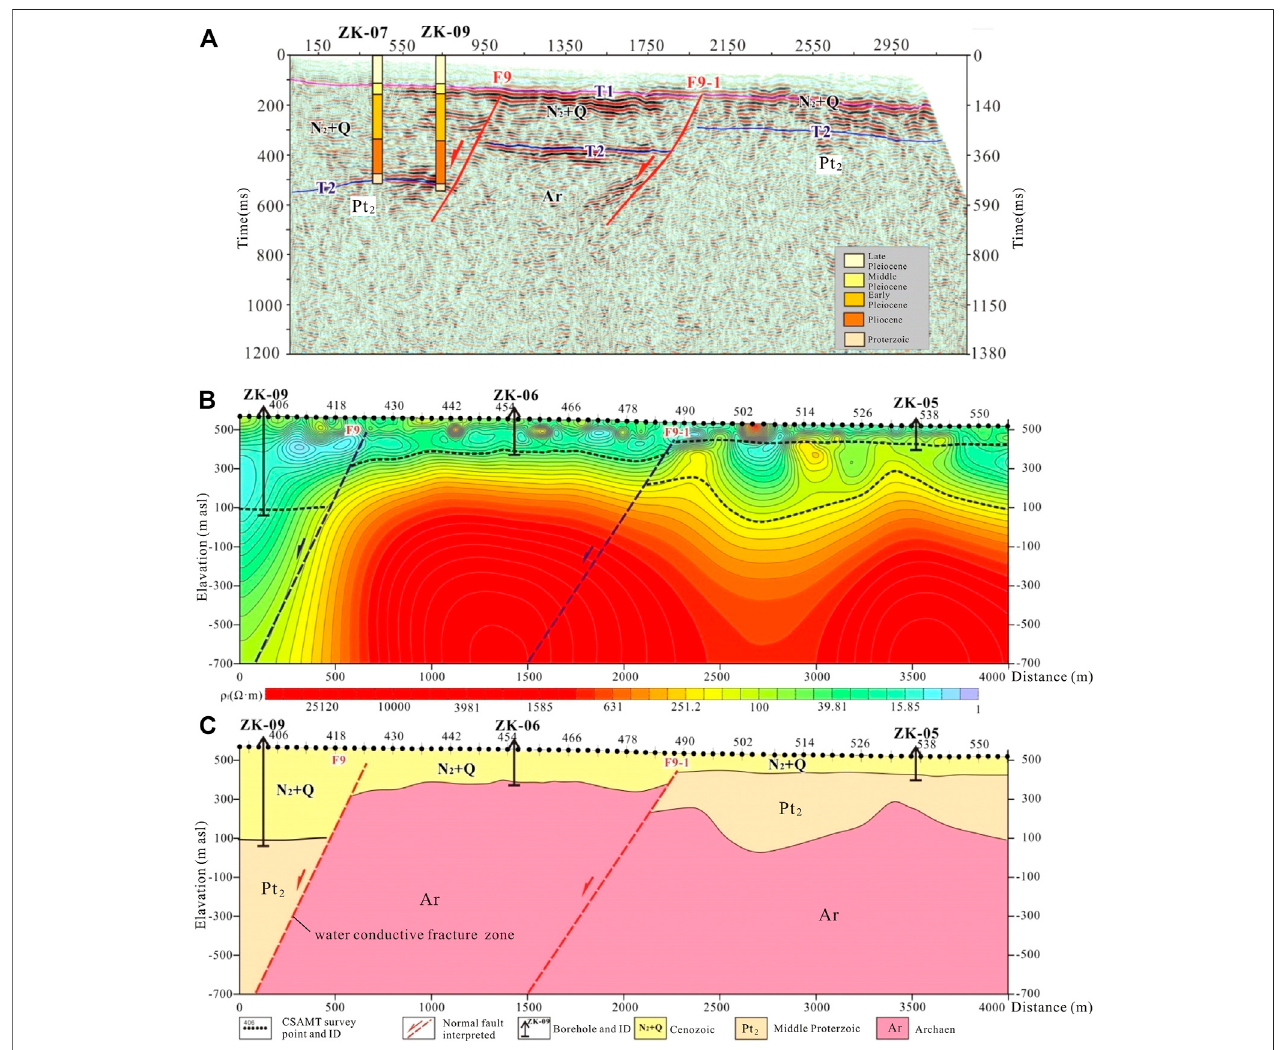
FIGURE 5 | Interpretation of faults from geophysical data (F 9 , refer to Figure 1 for the location). (A) 2D seismic time section. (B) CSAMT inversion section and geologic interpretation map. (C) Comprehensive geologic interpretation based on 2D seismology and CSAMT.